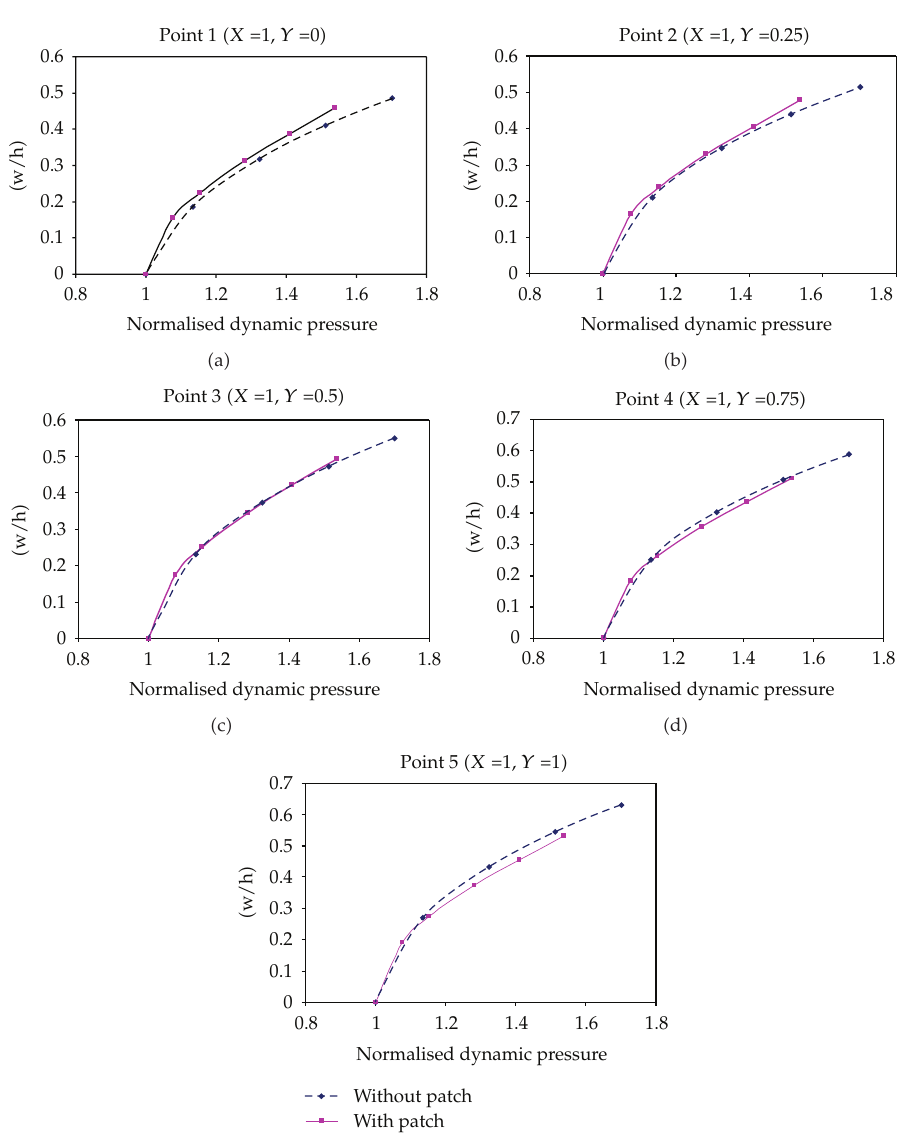
Figure 7: Amplitude of limit-cycle oscillations of a cantilevered plate on the free edge of the plate versus normalized dimensionless dynamic pressure (cid:3) λ/λ cr (cid:6) . Dimensionless coordinates of the studied points are presented in Table